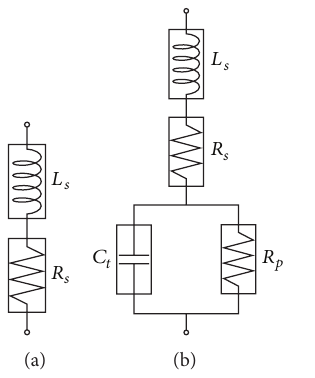
Figure 4: Pin diode equivalent circuits in the (a) forward and (b) reversed bias states.